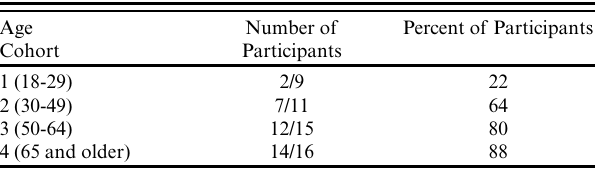
Table 3 . Observations of changing winter conditions by age